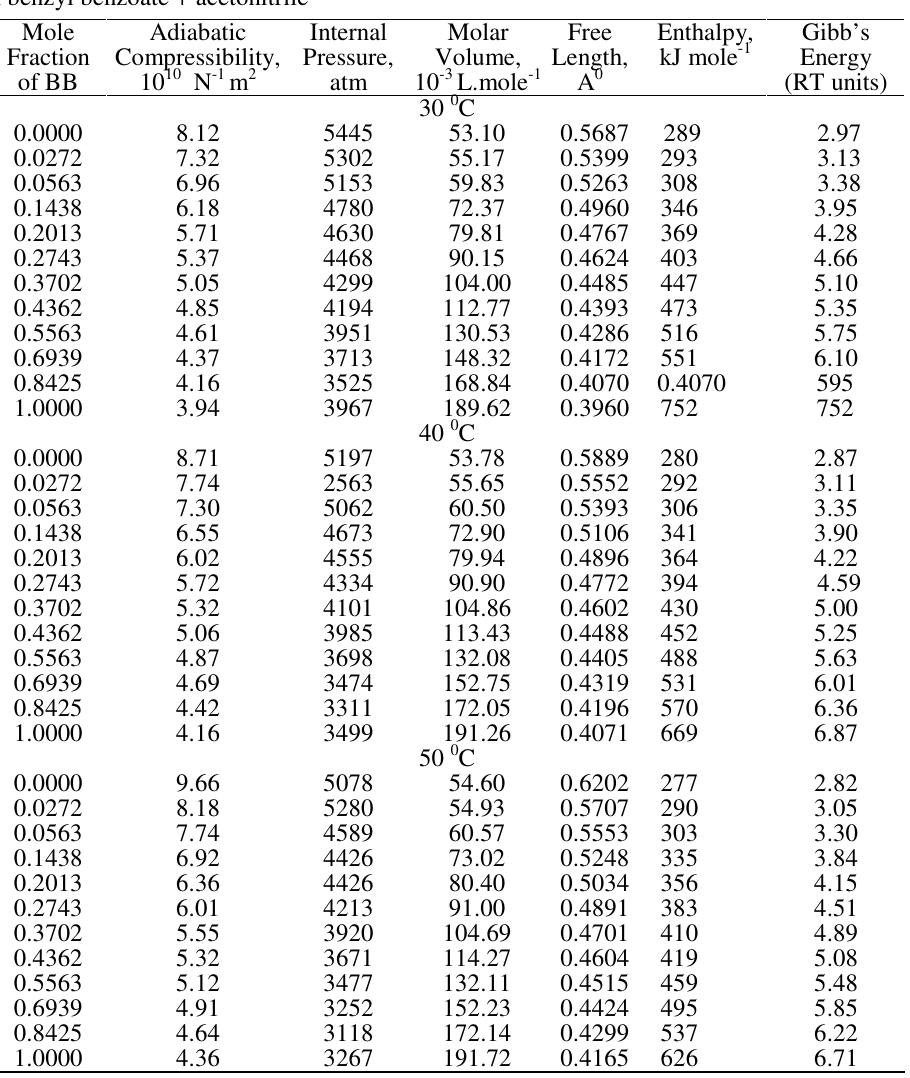
Table 2. Various parameters adiabatic compressibility, internal pressure, free